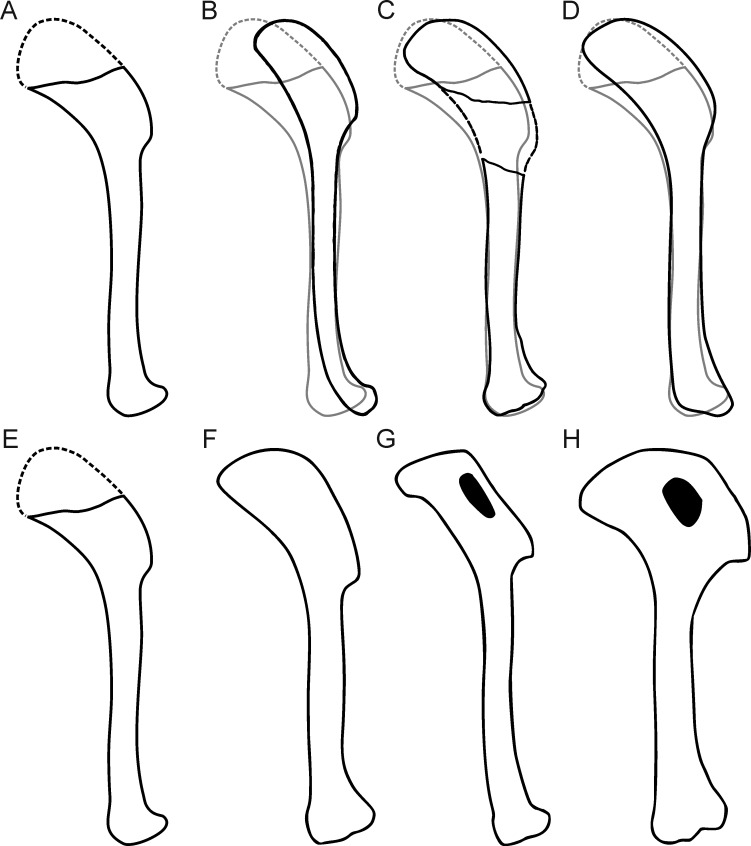
Comparison of humeral shape in some Mesozoic birds.(A, E) Alcmonavis. (B–D) Archaeopteryx with humeral shape of Alcmonavis shown in grey. (B) Berlin specimen. (C) Solnhofen specimen. (D) Daiting specimen. (F) Jeholornis. (G) Sapeornis. (H) Confuciusornis. (B, C) modified after Wellnhofer, 2008. (F–H) modified after Wang et al., 2016.